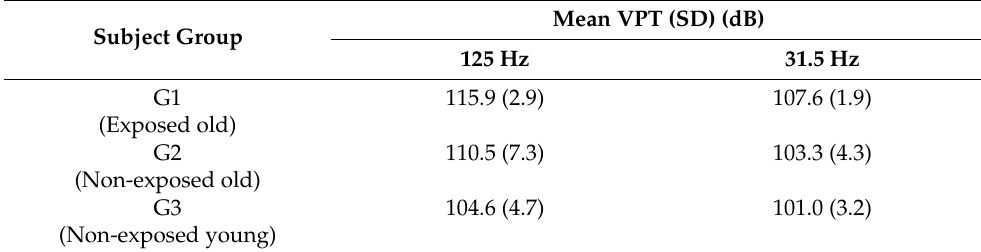
Table 3. Mean baseline VPTs in the three subject